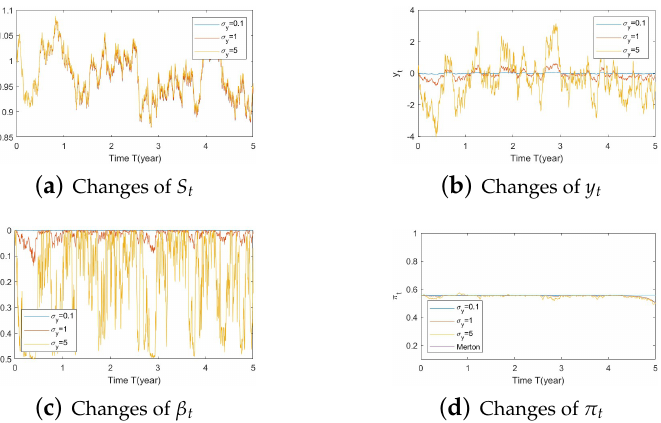
Figure A9. Illustrate the impact on ( a ) stock prices, ( b ) driver of elasticity, ( c ) elasticity of volatility, and ( d ) optimal stock allocations when varying σ y ( e . g ., σ y = 0.1,1,5 ) .